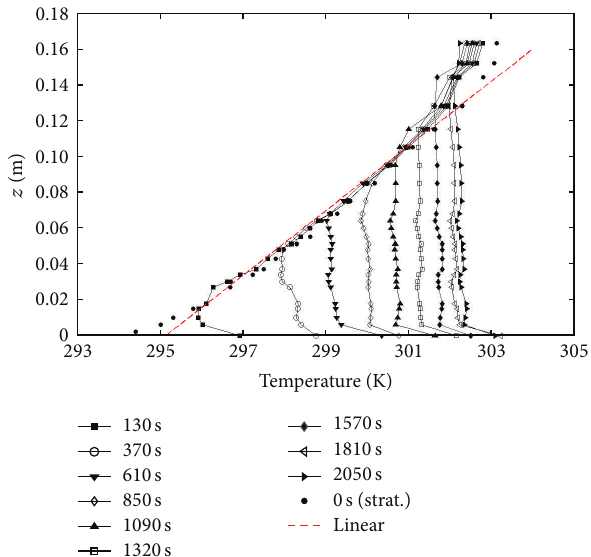
Figure 5: Temperature vertical profiles for experiment A2 (the stratification profile is the one at 𝑡 = 0 s).